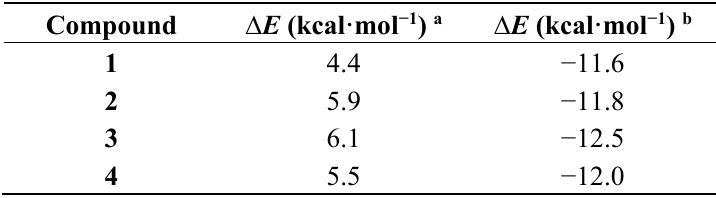
Table 6. Free energy changes for the transformations from enol-form to keto-form of the compounds at the ground state and excited